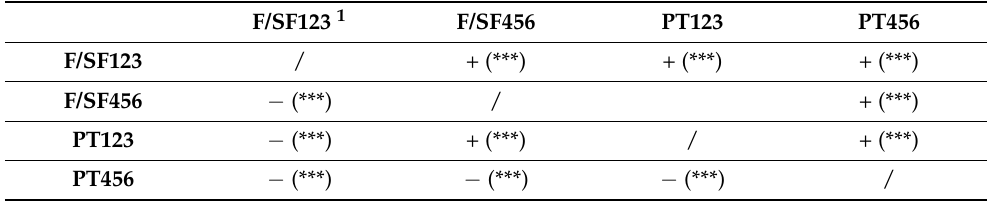
Table 14. The comparison of player levels’ influence on pacing strategy between Q2 and Q3.